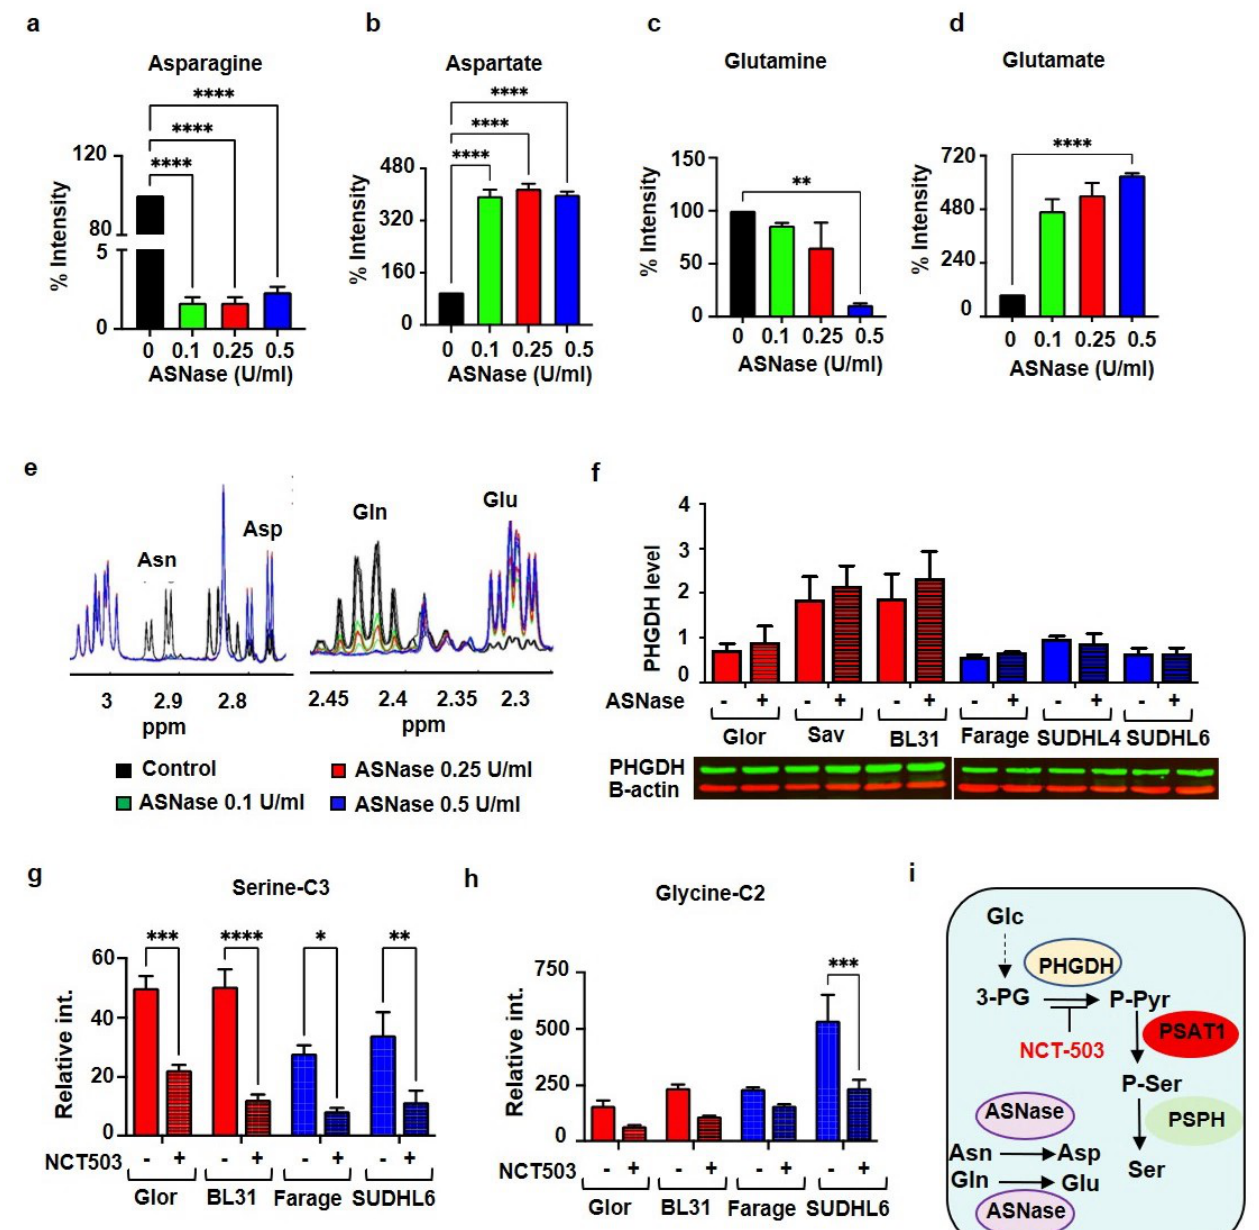
Figure 3. Comparison of serine metabolism in BL and DLBCL. Relative 1D 1 H-NMR peak intensity of ( a ) asparagine, ( b ) aspartate, ( c ) glutamine and ( d ) glutamate in the fresh medium supplemented without or with asparaginase (ASNase) at 0.1 U/mL, 0.25 U/mL and 0.5 U/mL for 24 h. ( e ) Representative 1D NMR spectra demonstrating the alteration in the level of asparagine, aspartate, glutamine and glutamate in medium supplemented with no ASNase, ASNase at 0.1 U/mL (green line), 0.25 U/mL (red line), 0.5 U/mL (blue line) for 24 h. ( f ) Western blot analysis showing the expression of PHGDH in Glor, Sav, BL31, Farage, SUDHL4 and SUDHL6 cell lines after treatment without or with 0.1 U/mL ASNase for 24 h. PHGDH level was normalized to β -actin. Analysis of 2D 1 H- 13 C HSQC spectra of ( g ) serine and ( h ) glycine extracted from Glor, BL31, Farage and SUDHL6 treated with NCT-503 at 10 µ M. Bar graphs represent mean ± SEM, with n = 3; * p < 0.05, ** p < 0.01; *** p < 0.001, **** p < 0.0001. ( i ) Illustration of the effects of ASNase and